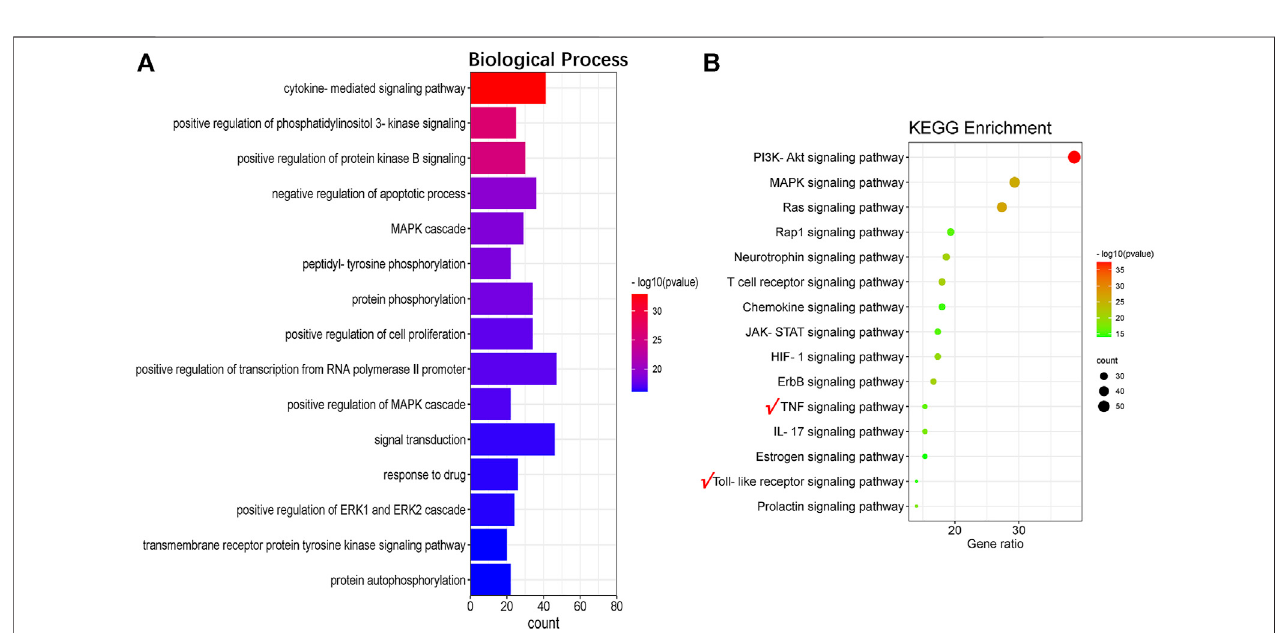
FIGURE 6 | Go analyses (A) and KEGG enrichment (B)